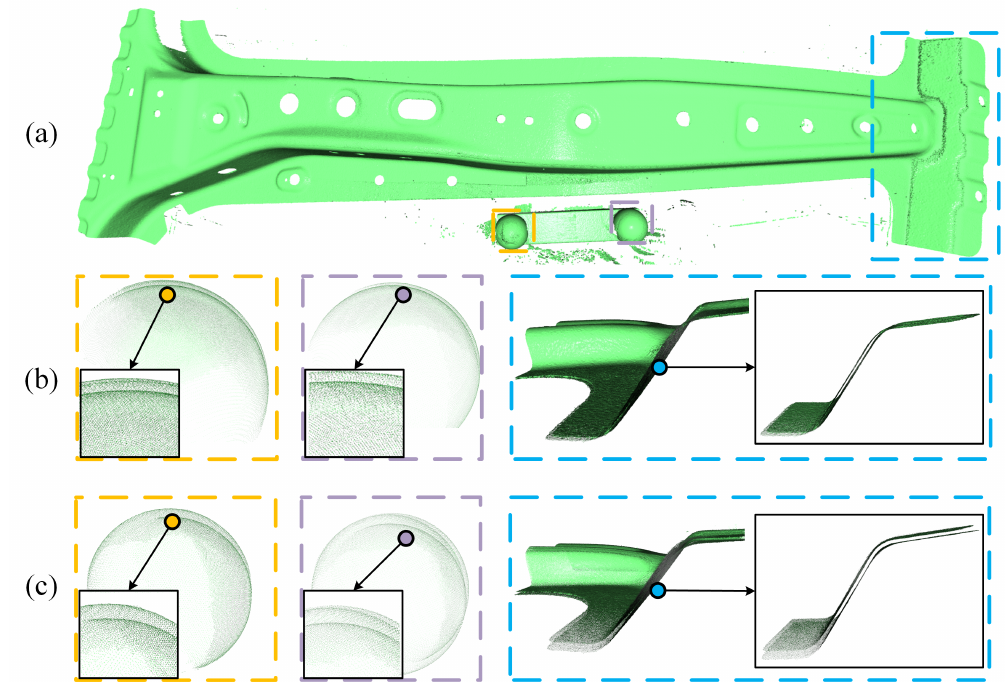
Figure 9. ( a ) The reconstructed surface and ( b ) Its local details using both geometric and curvature consistency constraints, ( c ) The corresponding local details using only geometric consistency constraints (its complete surface model not displayed